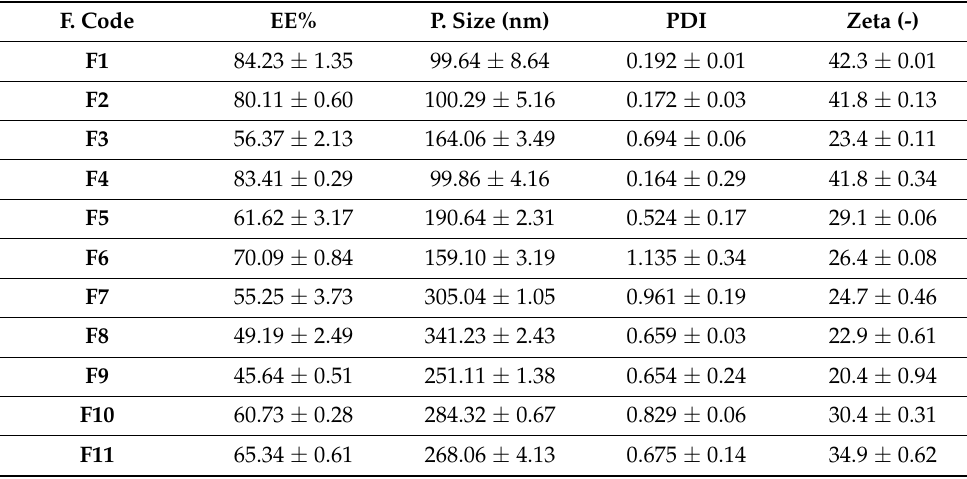
Table 3. Formulations results of EE%, particle size, PDI, and zeta